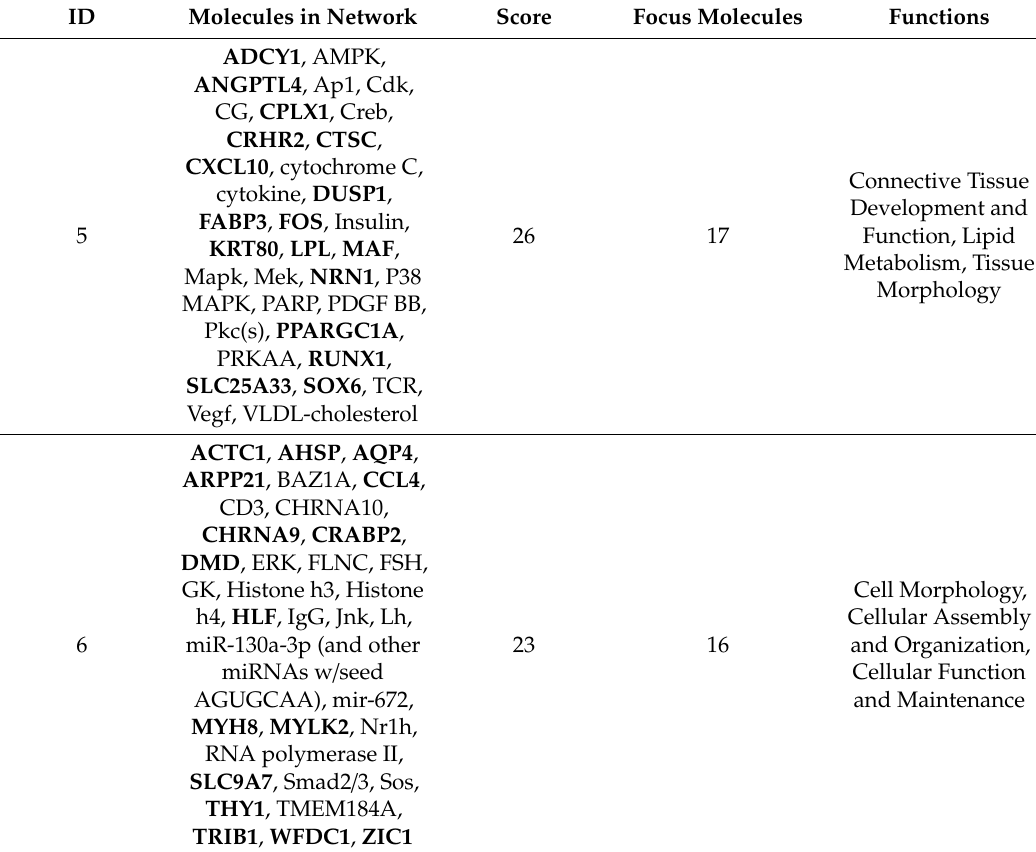
Table 3. List of relevant enriched networks and functions related with tenderness identified in the set of DEGs between the Tender and Tough groups identified by IPA software. Genes showing the highest expression di ff erences between groups are in